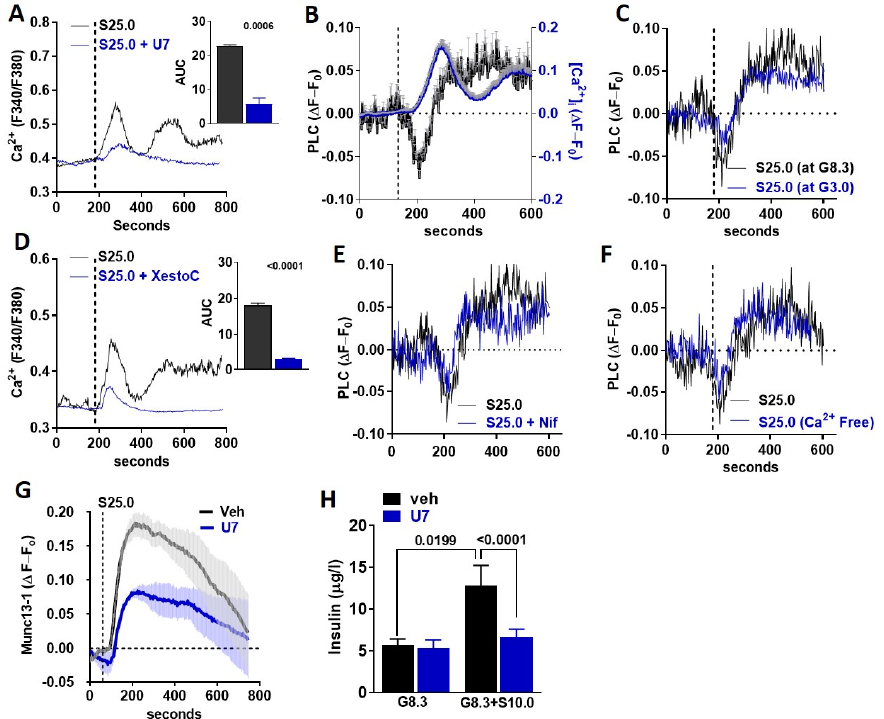
Figure 4. PLC activation is essential for saccharin-induced STR signaling ( A , D ) Representative traces of intracellular calcium response in MIN6 beta-cells treated (vertical line) with saccharin (S; 25.0 mM) with or without ( A ) U73122 (U7; 5.0 mM) and ( D ) xestospongin C (XestoC; 1.0 mM). Insets show area under curve (AUC) calculated as response X time. All experiments shown are average traces of 20–40 cells (n = 4–6 per group) and were performed in the presence of 8.3 mM glucose unless otherwise stated. Two-tailed unpaired T -test. ( B ) Average of traces (4–6 cells/trace total n = 6 independent experiments) showing relative change in PLC activity (left axis) or intracellular calcium (right axis) from baseline (set at 0) in MIN6 beta-cells treated (vertical line) with saccha- rin (25 mM) in the presence of glucose (8.3 mM). ( C , E , F ) Representative traces showing relative change in PLC activity from baseline set at 0 in MIN6 beta-cells treated (vertical line) with saccharin (S; 25 mM) in the presence of ( C ) glucose (G; 3.0 mM or 8.3 mM), ( E ) nifedipine (Nif; 1.0 mM), or ( F ) no extracellular calcium (Ca-free). Experiments were performed in the presence of 8.3 mM glucose, unless otherwise stated, and represent average of 4–6 cells. ( G ) Average of traces (4–6 cells/trace total n = 6 independent experiments) showing relative change in Munc13-1 activity from baseline (set at 0) in MIN6 beta-cells treated (vertical line) with saccharin (25 mM) in the presence of glucose (8.3 mM) with or without U73122 (U7; 5 mM). ( H ) Static insulin release in response to glucose (G; 8.3 mM) and saccharin (S; 10 mM) with or without U73122 (U7; 5.0 mM) in WT islets (n = 4–6 mice per group). ANOVA Fisher’s LSD post